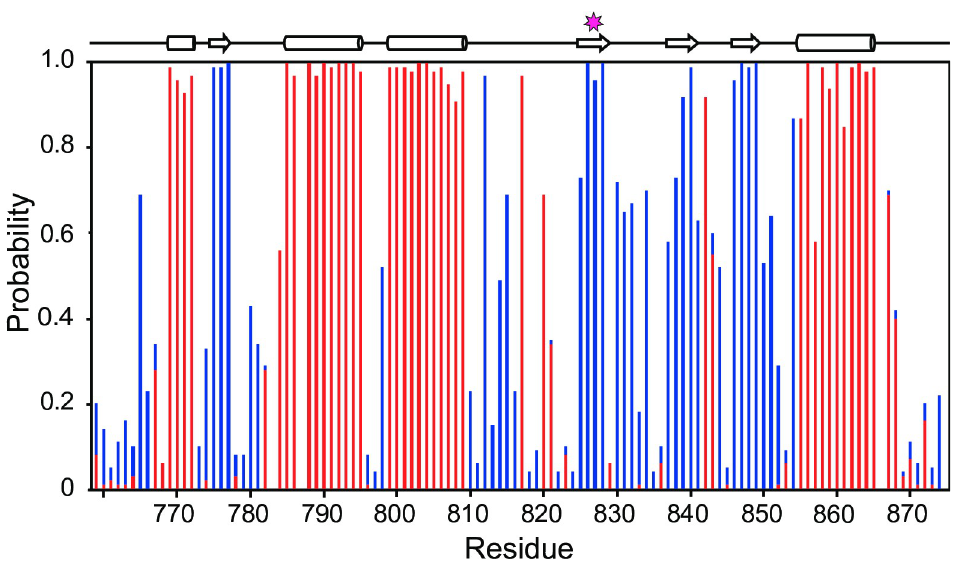
Fig 5. Predicted secondary structural regions of E6AP C-lobe . The probability plot was made by inputting the experimentally determined resonance assignments for E6AP C-lobe into the online webserver CSI 3.0 [64]. The propensity to form an α -helix or β -strand are denoted in red and blue, respectively. The position of the I827 residue is marked with a star.